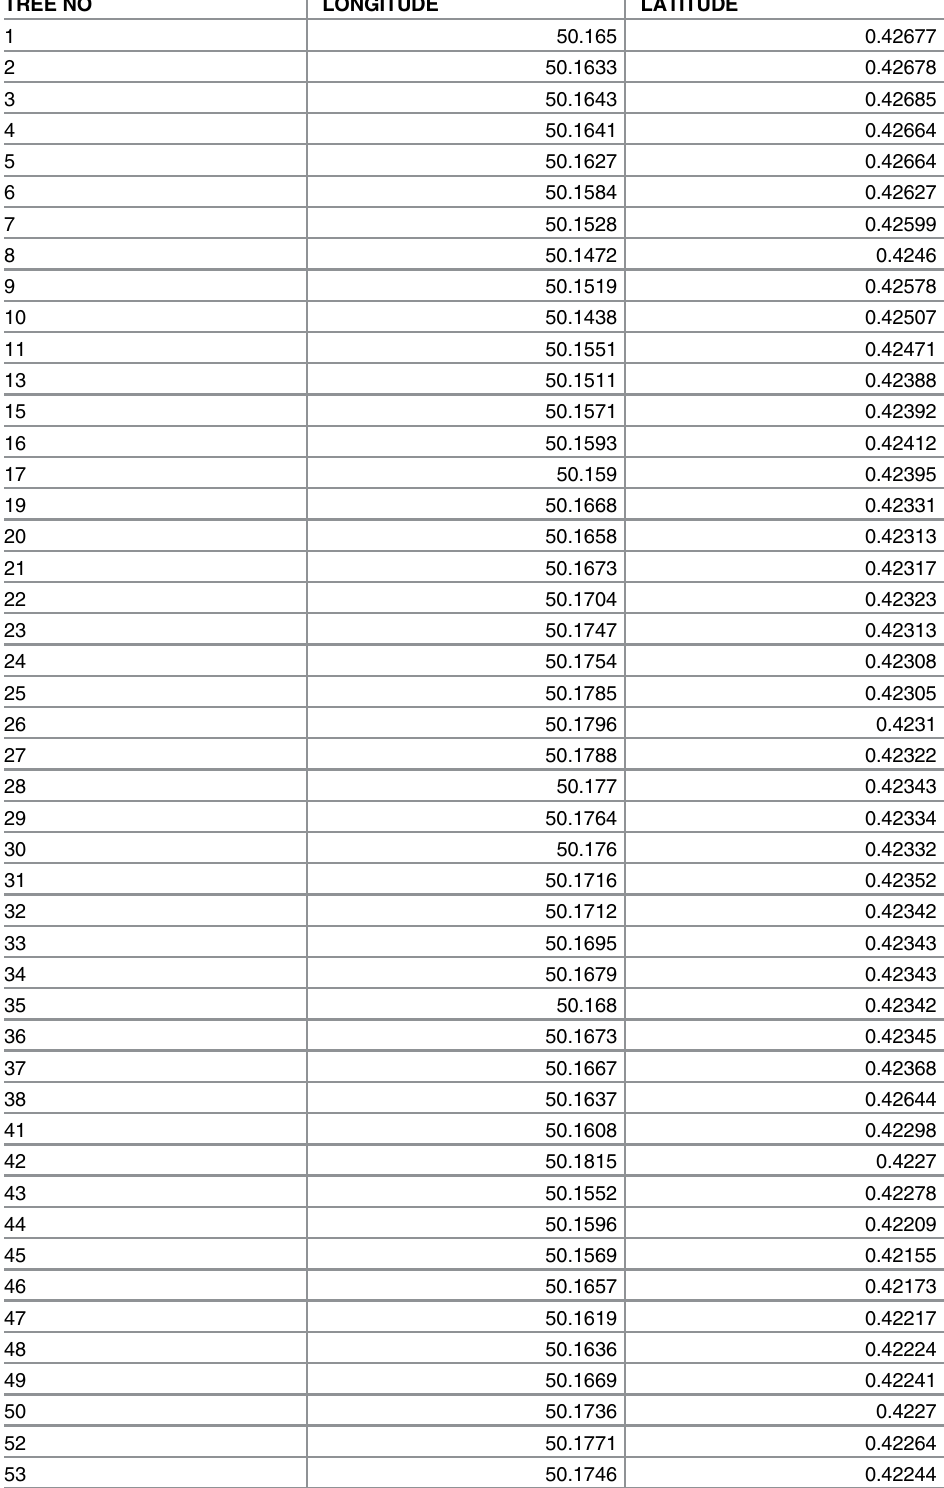
Table 1. GPS coordinates of all the Prunus africana trees that were sampled for analysis of S-alleles. TREE